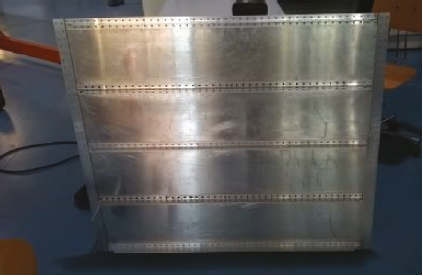
Figure 4: Aluminum panel used for the analyses. Table 1: Damaged scenario